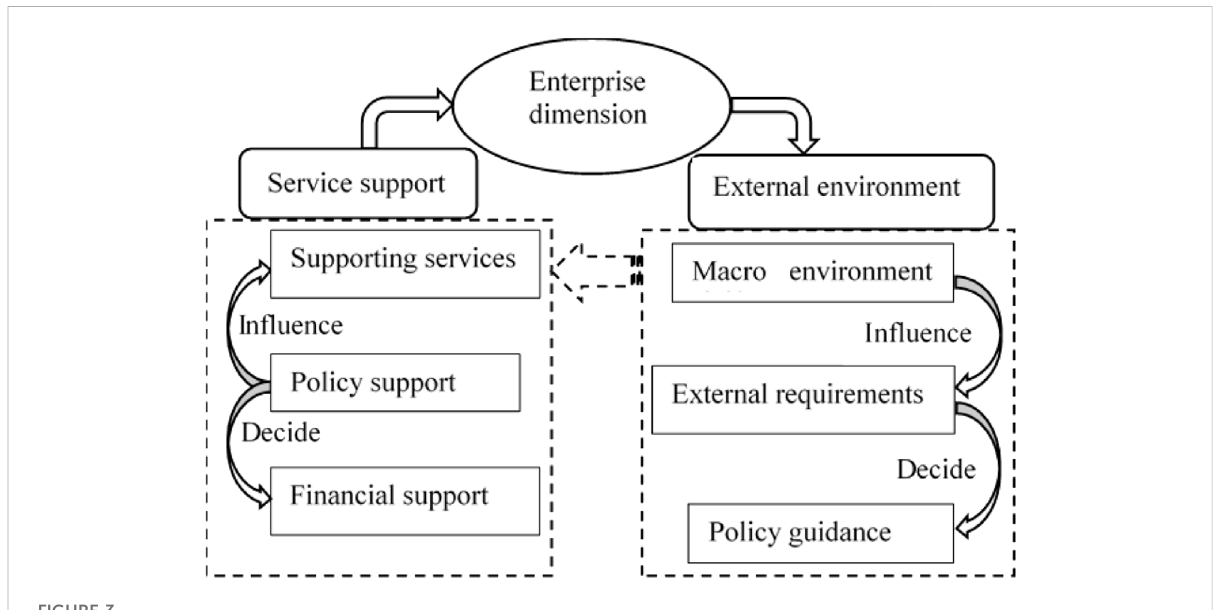
FIGURE 3 Environmental